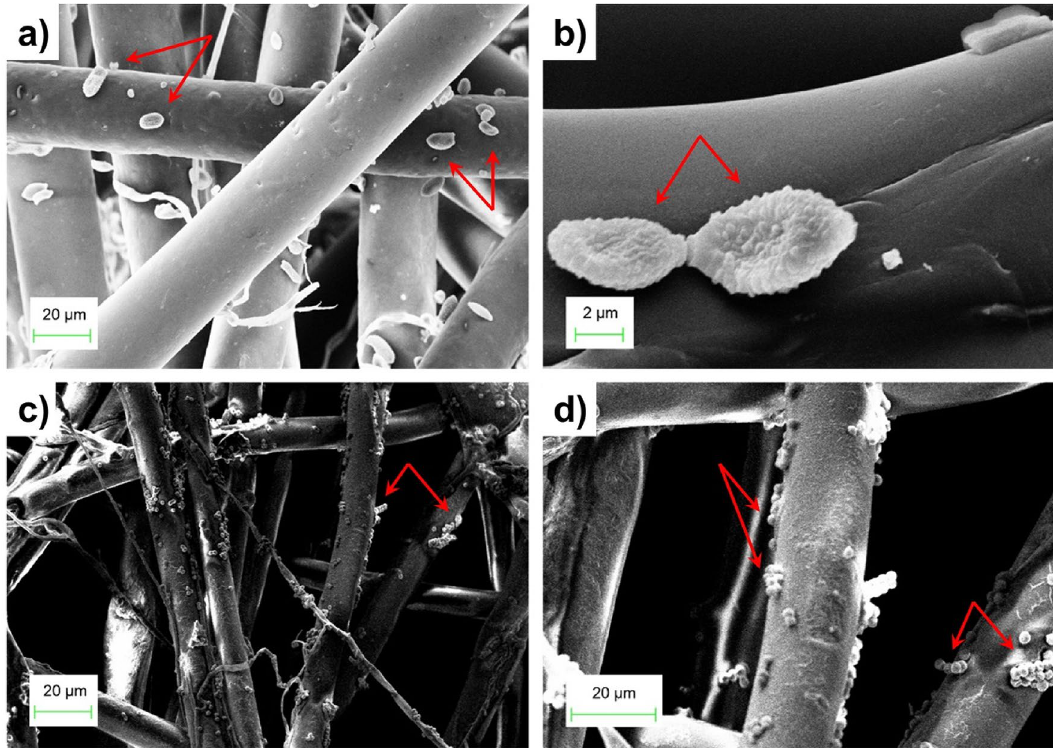
Figure 4. SEM insight: filaments of 24-h used FFP2 facemasks with fungi and spore